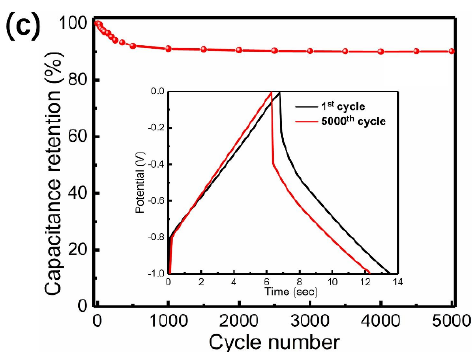
Figure 6. ( a ) The nyquist plots of PCS and PCS-MnO 2 - x ( x = 1, 2, 4) composites (inset: magnified semicircular part) ( b ) Linear fitting to the real part of impedance (Z ʹ ) versus the − 1/2 power of the angular frequency (w − 1/2 ) plots in a frequency range of 0.01 Hz to 0.1 Hz to estimate the ion diffusion resistance ( σ ) of PCS and PCS-MnO 2 composites. ( c ) The cycling performance at 10 A g − 1 of PCS-MnO 2 -2 (inset: comparison of the first and the last charging-discharging cycle in cyclic stability test).